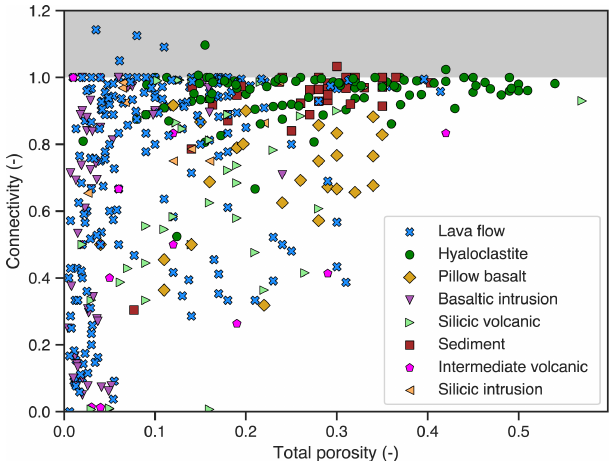
Figure 9. The relationship between pore connectivity and total porosity. Samples categorized by lithology. The gray fields corre- sponds to unphysical values of connectivity ( C > 1), which could result from variability in grain density (see